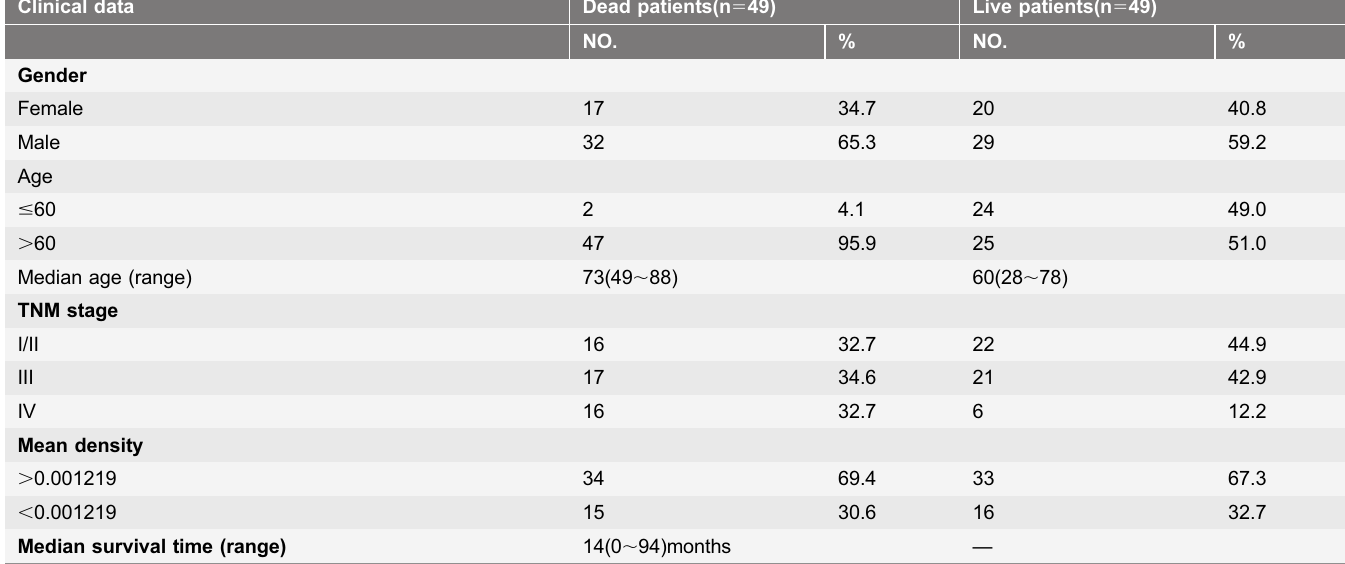
Table 2. Clinical data and mean density of deceased colon cancer patients and live cancer patients in Immuunohistochemical study. Clinical data